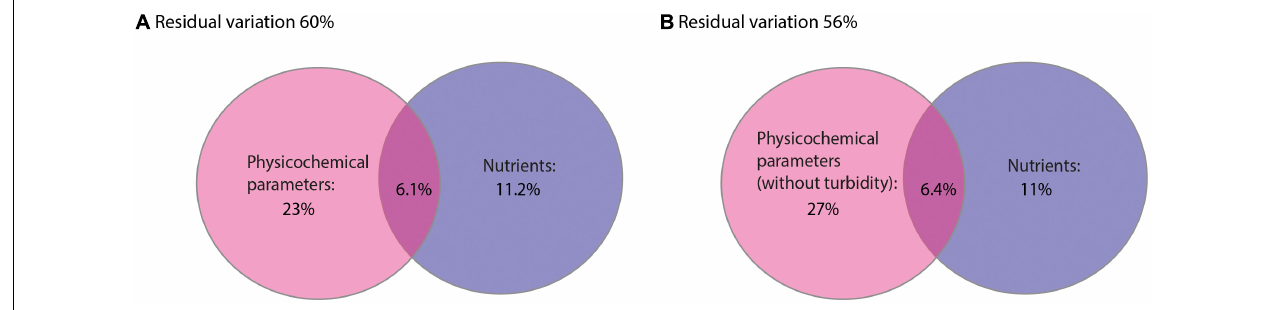
FIGURE 8 | Venn diagrams displaying the results of the variation partitioning analysis (VPA). The two explanatory matrices used contained variables on lake internal physicochemical parameters (A) (temperature, dissolved oxygen, turbidity, conductivity and pH) and nutrients (total dissolved phosphorus and nitrate). (B) (temperature, dissolved oxygen, conductivity and pH) and nutrients (total dissolved phosphorus and nitrate). Each circle represents the portion of variation accounted for by each explanatory matrix or a combination of them. The significance of the fractions of variability explained by the categories was determined via a Monte Carlo permutation test ( n = 999).